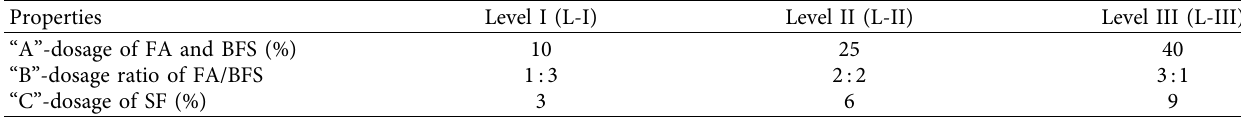
Table 3: The orthogonal experimental design of concrete with multiadmixtures in this paper.